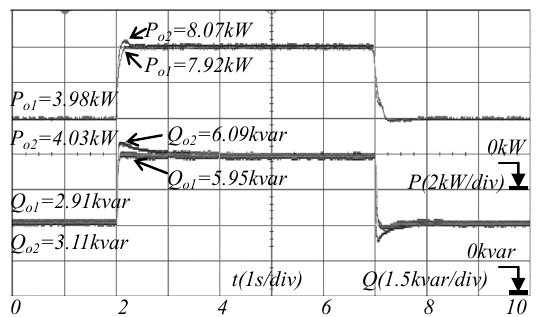
Figure 16. The performance of power sharing with a time delay difference in communication system.